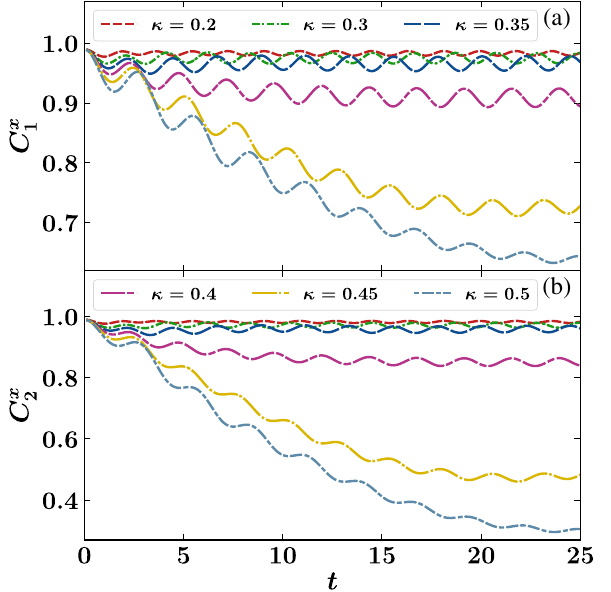
FIG. 2. Time evolution of (a) C x 1 and (b) C x 2 for six values of κ after quenches starting from the ground state of the ANNNI Hamiltonian with Γ ¼ 0 . 2 and κ I ¼ 0 .